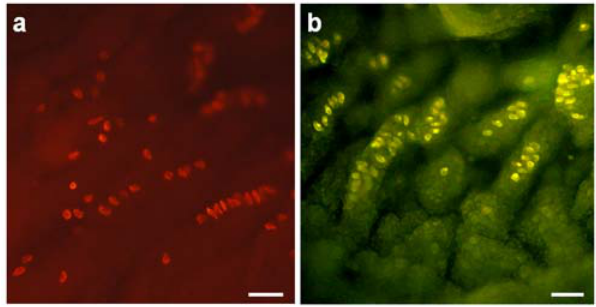
Figure 11. FM1–43 stained neurosecretory granules of MCs. FM1–43 is a fluorescent dye and a permeant blocker of mechanosen- sory channels, which stained the neurosecretory granules of neurons, hair cells, and MCs. (a) MCs are concentrated in rat footpads as demonstrated by CK20immunostaining. (b) Intraperitoneal injection of FM1–43 at 3 mg/kg in the rat allows for identification of MCs in the basal layer of the epidermis of rat footpads. Scale bars: 50 m m.